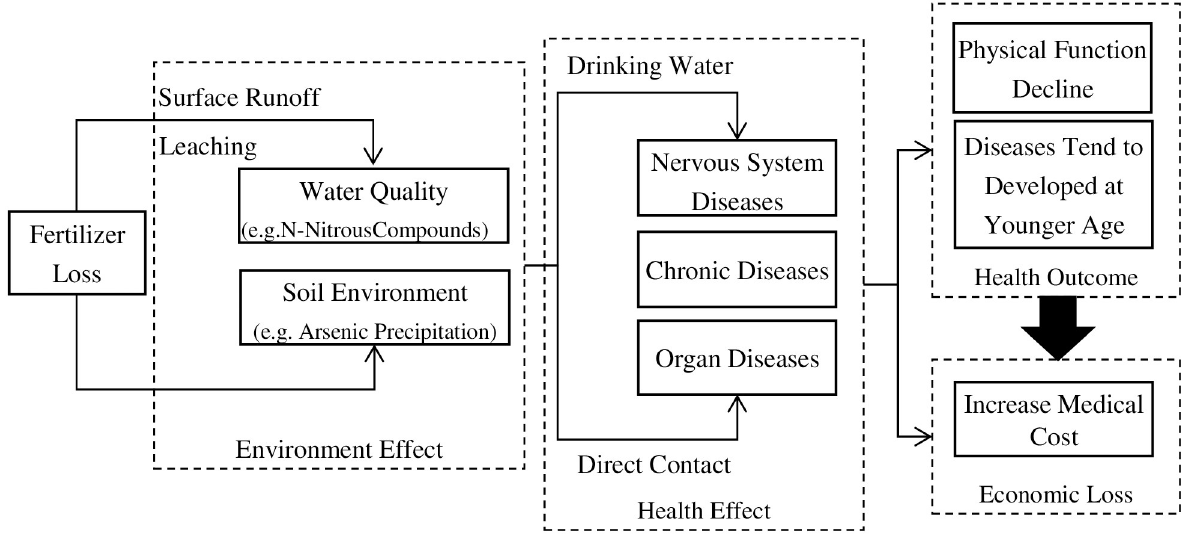
Fig 1. Effects of chemical fertilizer loss on